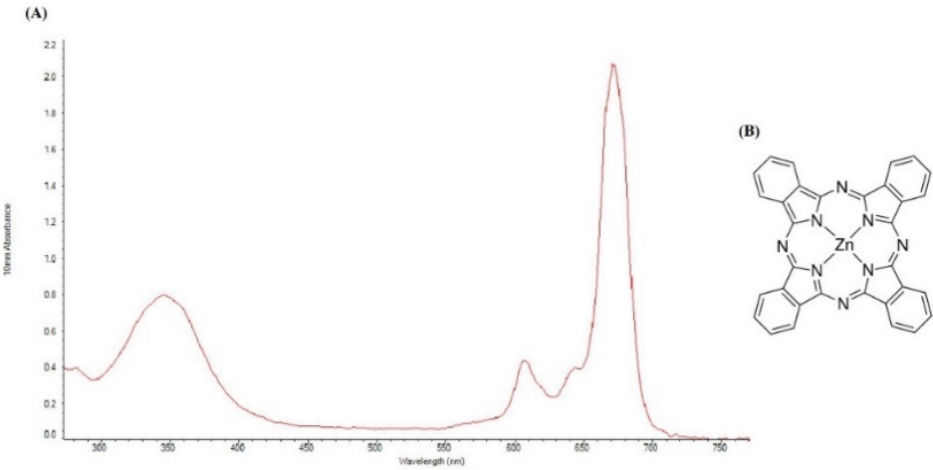
Figure 9. ( A ) UV–vis spectrum of 8.651 μ M of ZnPc in DMSO. ( B ) Structure of ZnPc.